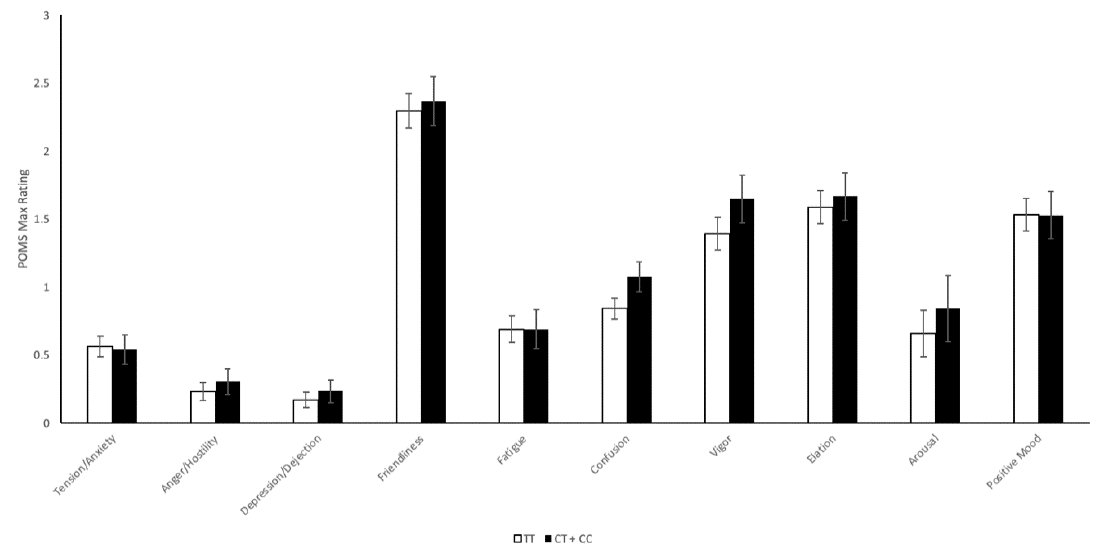
Figure 5. CNR1 rs2023239 Aggregate Profile of Mood States Maximum Values. Unadjusted maximum Profile of Mood States (POMS) questionnaire results (measured on a scale of 0–4), measured at baseline and 1 h post-cannabis exposure of n = 52 subjects, separated by rs2023239 genotype: Tension/Anxiety ( p = 0.876), Anger/Hostility ( p = 0.511), Depression/Dejection ( p = 0.526), Friendliness ( p = 0.750), Fatigue ( p = 0.999), Confusion ( p = 0.098), Vigor ( p = 0.239), Elation ( p = 0.706), Arousal ( p = 0.538), and Positive Mood ( p = 0.988). * p < 0.05, CT + CC vs. TT. Split-plot ANOVA analyses were con-